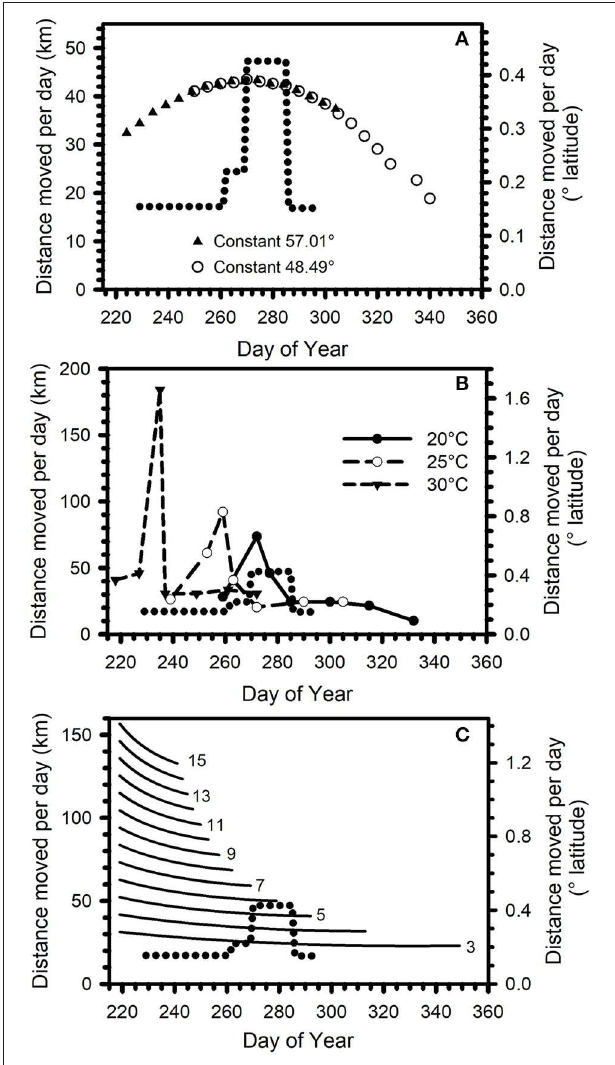
FIGURE 4 | (A) Daily movement distance (km) or daily degrees of latitude traversed to maintain a constant 57.01 ◦ SASN (triangles) (7 August departure) and a constant 48.49 ◦ SASN (open circles) (2 September departure) on a 3,300-km migration from 49.34 ◦ N to ∼ 19.5 ◦ N latitude along longitude 100.3 ◦ W. (B) Daily movement distance (km) or daily degrees of latitude traversed to reach locations on the first day the historical mean daily maximum temperature is 20 ◦ C (filled circles), 25 ◦ C (open circles), 30 ◦ C (filled triangles) on a 2,947-km migration from 49.34 ◦ N to 22.82 ◦ N latitude along longitude 100.3 ◦ W. (C) Daily movement distance (km) or daily degrees of latitude traversed predicted for monarchs flying at constant flight speed for 70% of the daylight hours. Shown for 7 August on a 3,300-km migration along longitude 100.3 ◦ W from 49.34 ◦ N to ∼ 19.5 ◦ N latitude. Number next to each line represent hourly flight speeds (km h − 1 ) (lines are in 1-km h − 1 increments, every other line numbered). On each graph, dotted curve represents the daily movement rates derived from day-over-day changes in mean Monarch Watch tagging latitudes between days-of-year 229–296 as shown in Figure 3